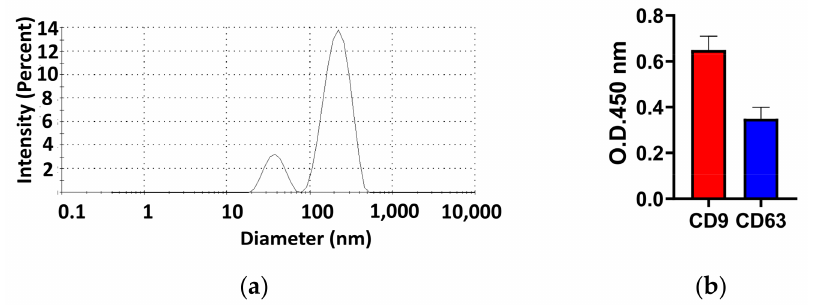
Figure 1. The characterization of the diameter and the surface proteins of exosomes. ( a ) The diameter of exosomes was characterized by a Zetasizer Nano. ( b ) The level of CD9 or CD63 surface protein on exosomes was characterized by ELISA.